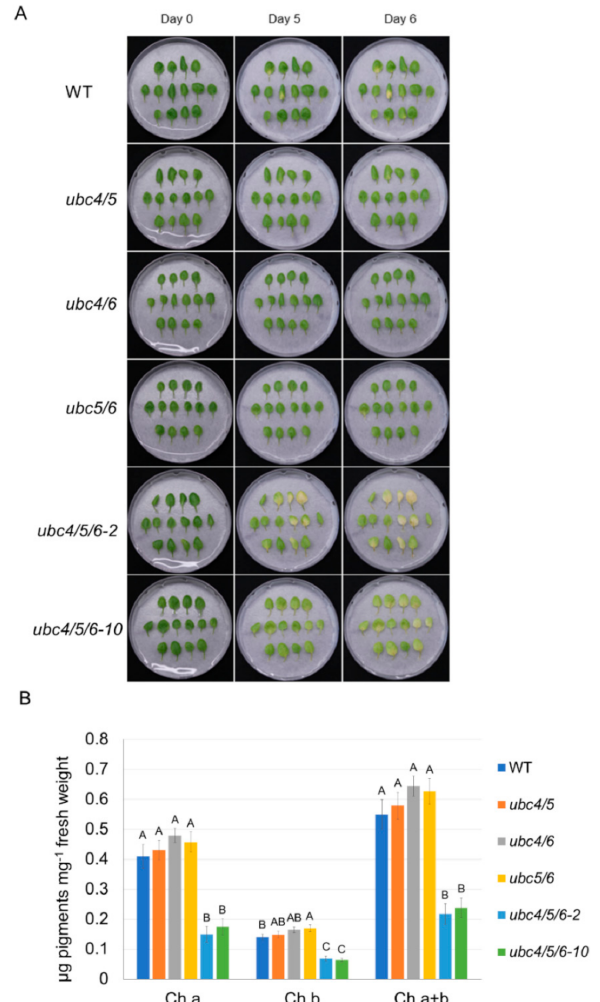
Figure 7. Analysis of early leaf senescence phenotype in different double and triple mutants of UBC4 , UBC5 , and UBC6 . ( A ) Dark-induced senescence of detached leaves from 5-week plants of the WT, ubc4/5 , ubc4/6 , ubc5/6 double mutants, and two lines of the ubc4/5/ 6 triple mutant ( ubc4/5/ 6-2 and ubc4/5/ 6-10). The second pair of true leaves were detached from plants and used in the assay. They were placed in Petri plates on a piece of filter paper with 4 mL of H 2 O added. These plates were covered with a layer of lab bench absorbent paper and incubated at room temperature for 6 days. Pictures were taken before (Day 0) and after the dark treatment (Day 5 and Day 6). ( B ) Chlorophyll content analysis of the detached leaves after the 6-day dark treatment in ( A ). Each datum (in µ g of pigments mg − 1 fresh weight) represents the average of three replicate samples (with each sample having five detached leaves). The error bars indicate standard deviations. Data were analyzed using one-way ANOVA and post-hoc Tukey test, and significant differences are indicated by different letters (upper case) at p < 0.01